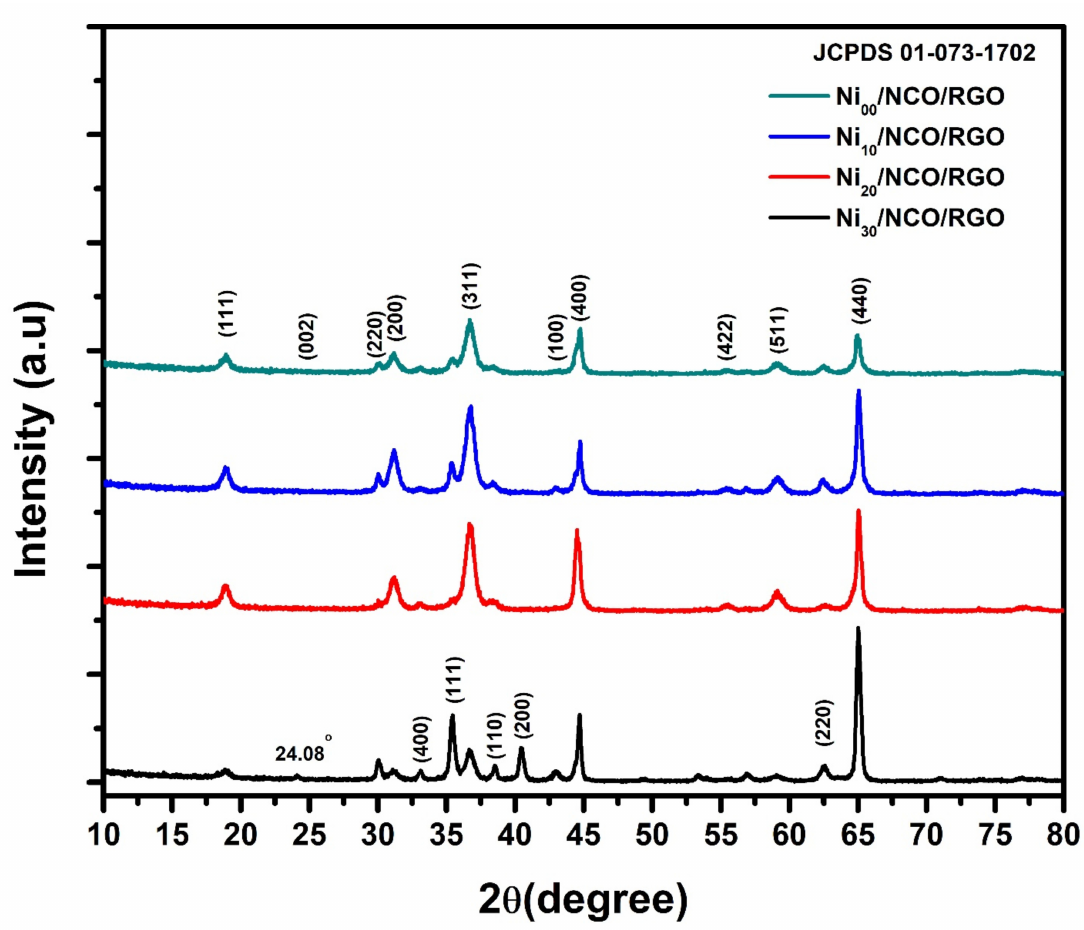
Figure 1. X-ray diffraction (XRD) patterns of various Ni/NCO/RGO hybrid nanostructures with different substrate etching